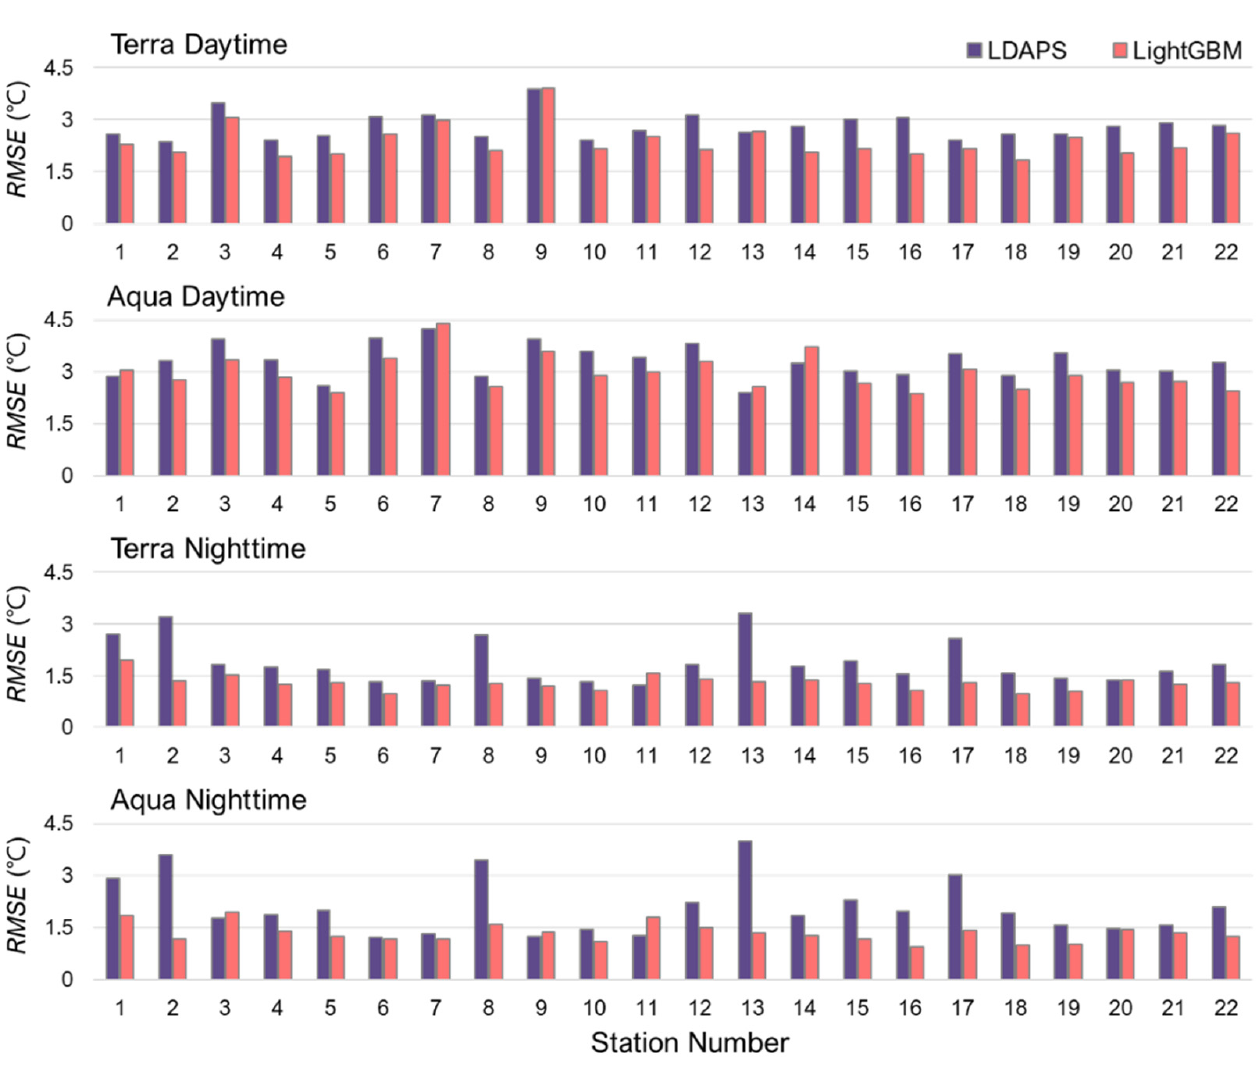
Figure 6. RMSEs for cloudy-sky LSTs from the LDAPS and proposed LightGBM models against the bias-corrected in situ LST measurements for each ASOS. Please refer to Figure 1 for station numbers. Figures 7 and 8 depict the spatial maps of the average all-sky 1 km LST of the LDAPS and LightGBM models for daytime and nighttime, respectively, in June–August from 2013 to 2020. The daytime and nighttime LSTs of both models showed a negative spatial relationship with elevation (see Figure 1). While LDAPS showed a relatively smoothed spatial pattern of LST, LightGBM produced spatially detailed LST distribution. Figure 9 displays the original MODIS LSTs and the corresponding all-sky LSTs of LDAPS and LightGBM at both daytime and nighttime on 6 August 2016. As shown in Figure 4, the daily LST difference between MODIS and LDAPS was evident. Although the overall LST spatial patterns of LDAPS were similar to MODIS, they were spatially smoothed. On the contrary, the proposed model successfully filled the missing LST pixels without the smoothing